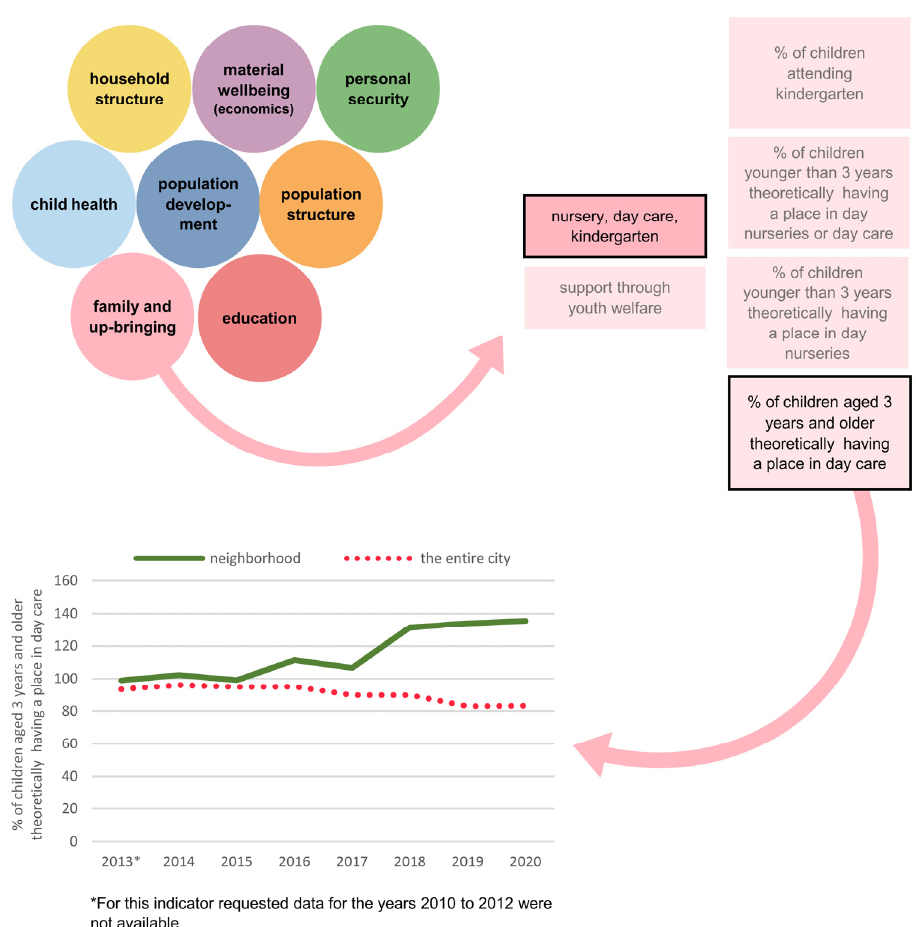
Figure 3. Example application of the neighborhood barometer .